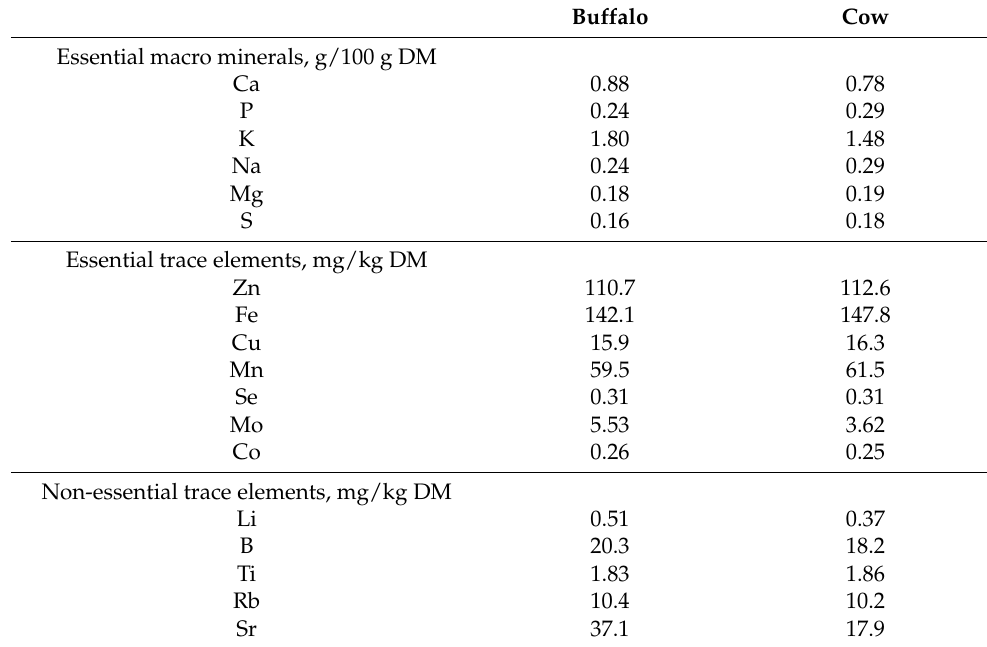
Table 4. Chemical elements composition of diets fed to buffaloes and